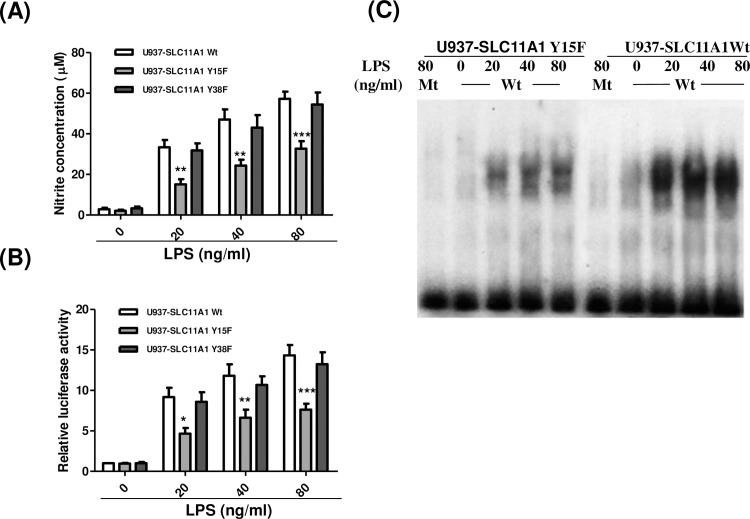
Effects of Tyr-15 to Phe substitution on SLC11A1-mediated NO production and NF-κB activation.U937 cells were stably transfected with constructed pCB6 vectors expressing c-Myc-tagged wild-type (U937-SLC11A1 Wt) or mutated SLC11A1 (U937-SLC11A1Y15F and U937-SLC11A1Y38F). (A) Stably transfected cells were treated with PMA (10ng/ml) for 72hrs. Then, the medium was replaced with fresh medium containing various concentrations of LPS as indicated and the cells were continuously cultured for 24 hrs. Release of NO was measured using Griess reagent (mean ± S.E., n = 4, **P <0.01, *** P <0.001). (B) U937-SLC11A1Wt, U937-SLC11A1Y15F and U937-SLC11A1Y38F cells were transiently co-transfected with 1.5 μg of pGL4.32[luc2P/NF-κB-RE/Hygro] vector and 0.5 μg pRL-TK vector (as an internal control). Six hours after transfection, cells were incubated in the presence of PMA (10 ng/ml) for 72 hrs. Then, the medium was replaced with fresh medium containing different concentrations of LPS as indicated and the cells were incubated for another 24 hrs, and subjected to luciferase assays. Relative luciferase activity is expressed as a fold of the luciferase activity of U937-SLC11A1Wt cells without treatment with LPS. The data shown (mean ± S.E.) are the averages of three independent experiments performed in triplicate. *P < 0.05, P < 0.01, ***P < 0.001, when compared with U937 cells expressing mutant SLC11A1. (C) U937-SLC11A1Wt or U937-SLC11A1Y15F cells were treated with PMA (10ng/ml) for 72 hrs, followed by treatment with various concentrations of LPS (0, 20, 40 and 80 ng/ml) for 24 hrs. Nuclear extracts were incubated with γ-32P-labeled wild type NF-κB oligonucleotides (Wt) or mutant NF-κB oligonucleotides (Mt). DNA-protein complexes were run on 4% non-denaturing polyacrylamide gels, followed by autoradiography.